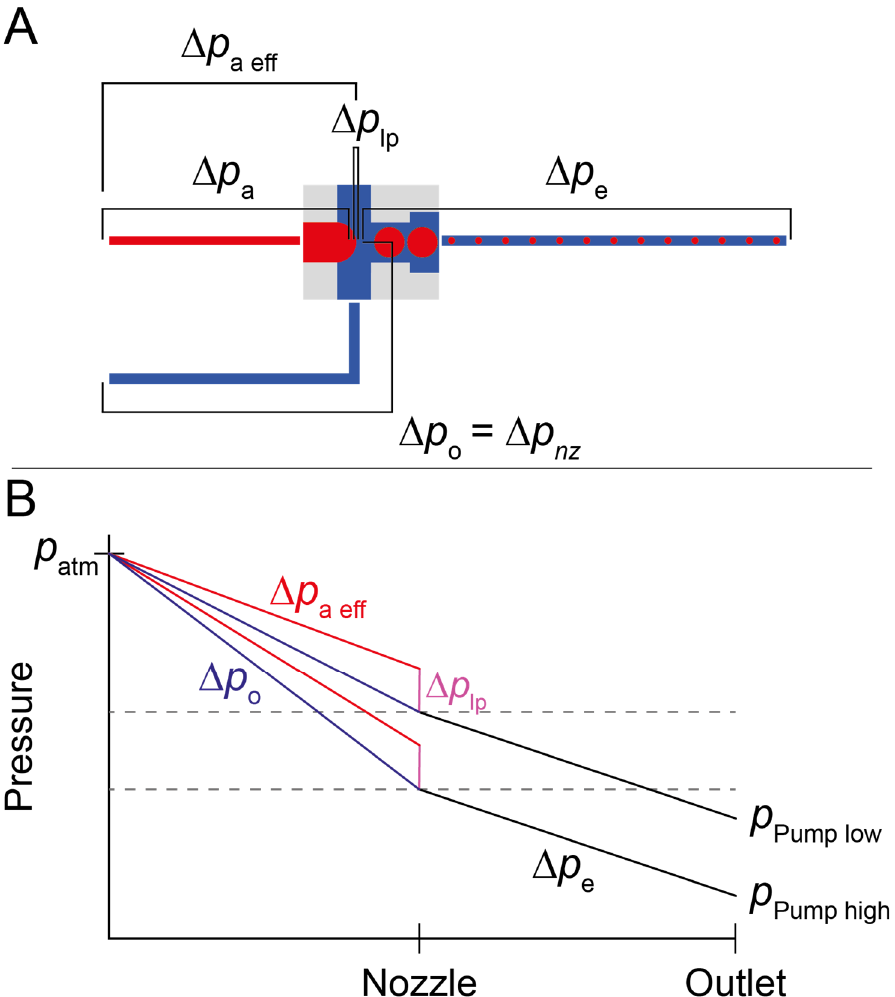
Figure 5. Pressures in the microfluidic system. ( A ) shows a schematic depiction of the microfluidic circuit with the respective pressure differentials and with the two oil channels collapsed into one. Red depicts the aqueous phase, blue the continuous phase. ( B ) represents the idealized pressure along the circuit geometry. Note that ∆ p lp is not constant in reality, however, the change is minuscule enough to be disregarded for our purposes.